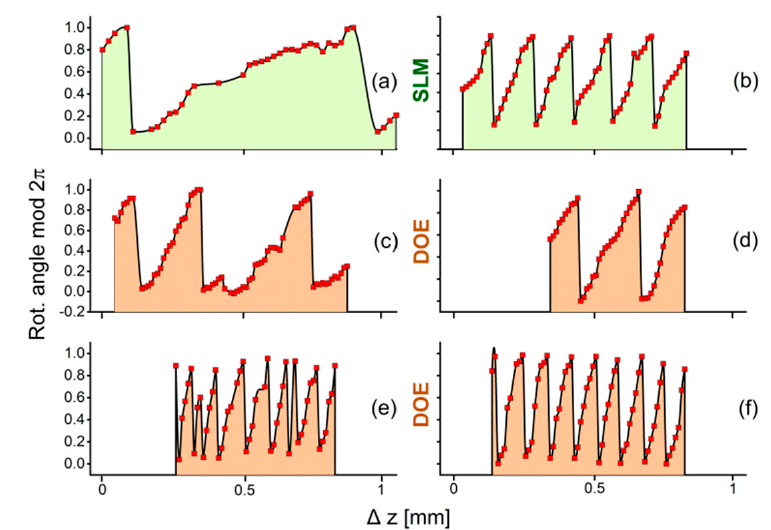
Figure 6. Propagation-dependent maps of 1st spectral moment (COG) of experimentally detected maps of local spectra for two different vortex shaper configurations programmed in an LCoS-SLM (aperture D = 2 mm): ( a ) generation of a Bessel–Gauss beam with a spiral phase grating (SPG) with spectral Gouy rotation (spiral grating period p = 16 µm) (see also video S1 in the Supplementary Materials); ( b ) vortex generation with a spiral phase plate (SPP), without spectral Gouy rotation. The little grey scale pictures at the left side symbolize the type of element (SPG, SPP).